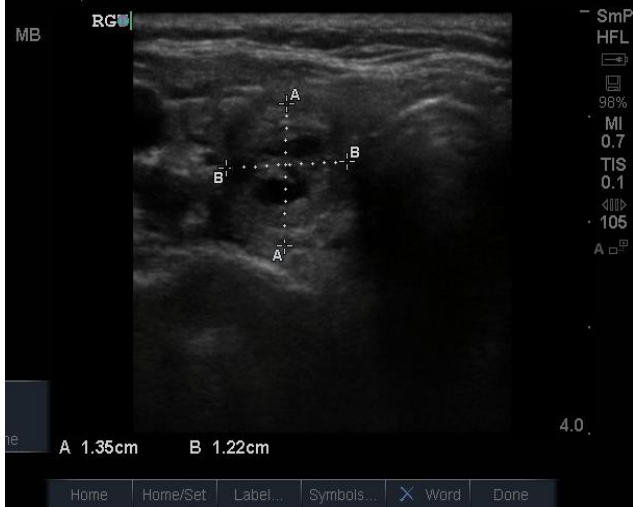
Figure 18. Thyroid ultrasound from a patient with hyperparathyroidism showing a hypoechoic lesion below the right thyroid lobe that was confirmed to be a parathyroid adenoma at